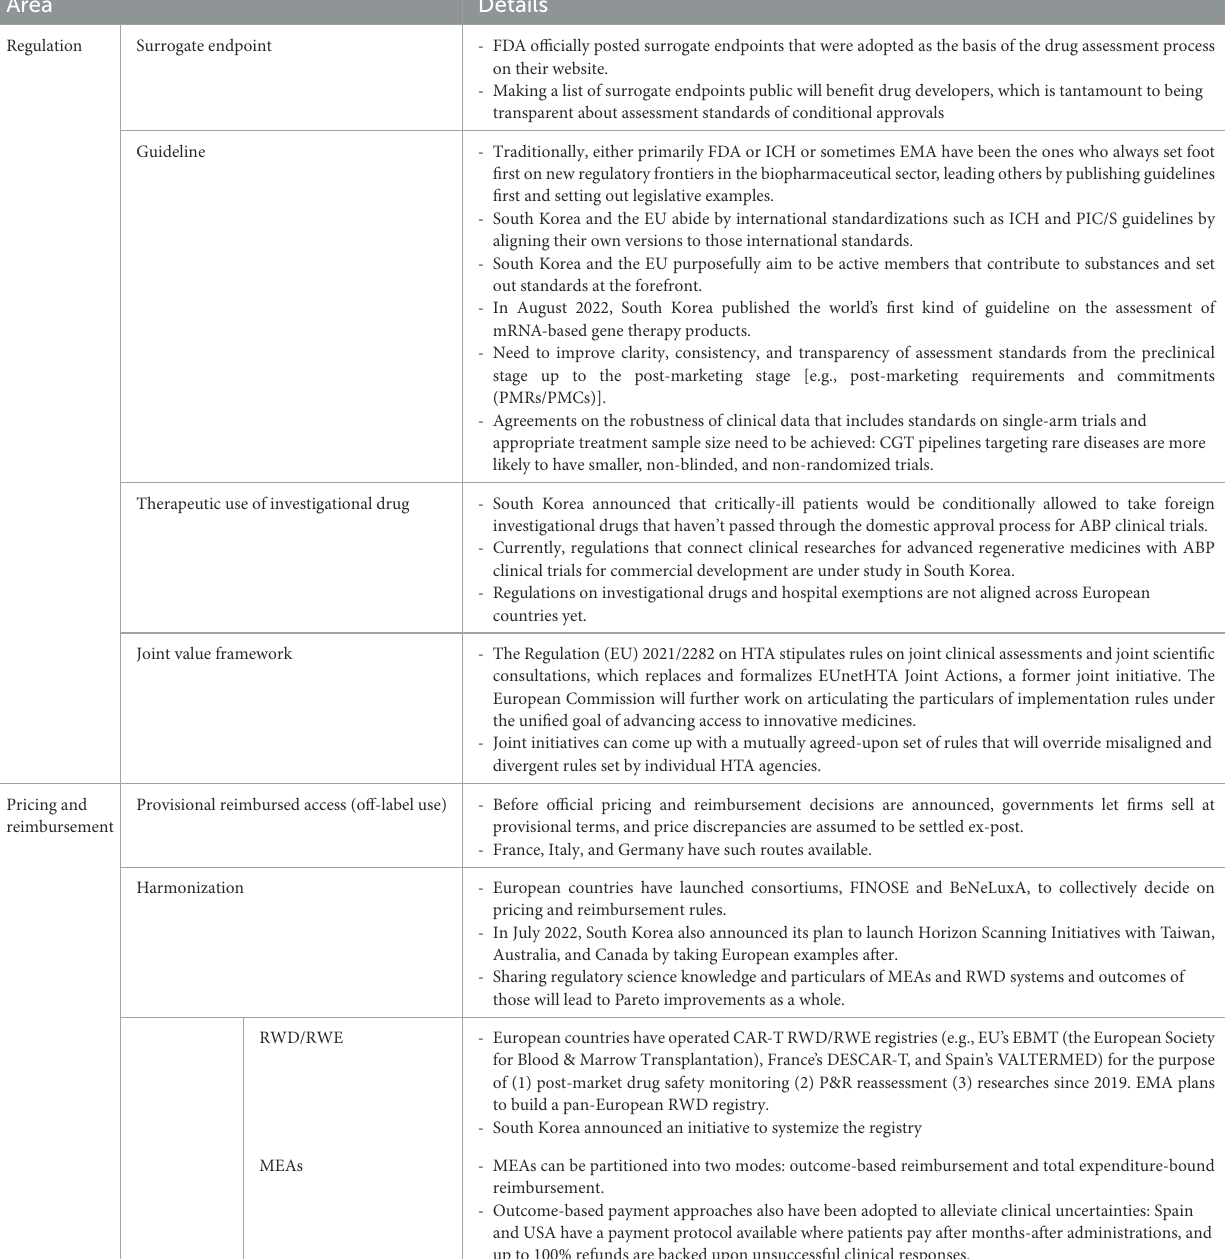
TABLE 8 Regulatory elements to get across and harmonize (5, 30, 31, 44, 45,